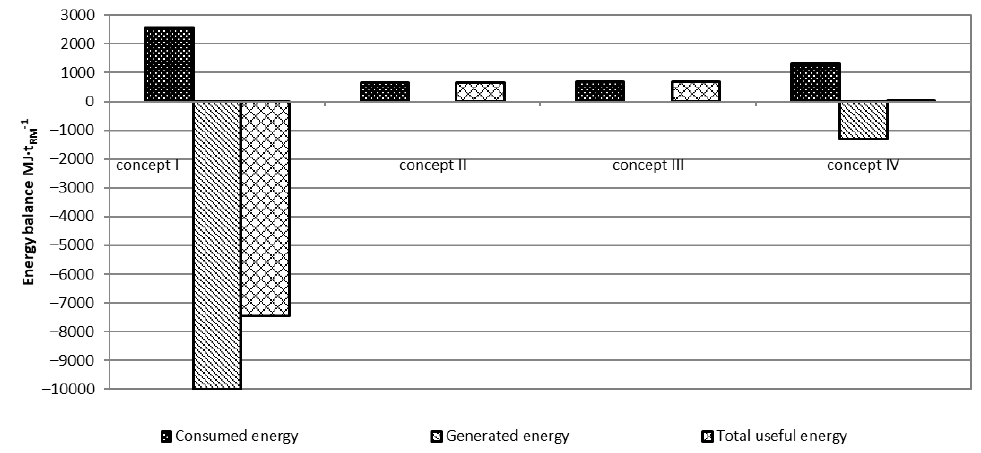
Figure 7. Total energy balance. Note: positive numbers indicate energy consumption while negative indicate energy indicate energy generation.